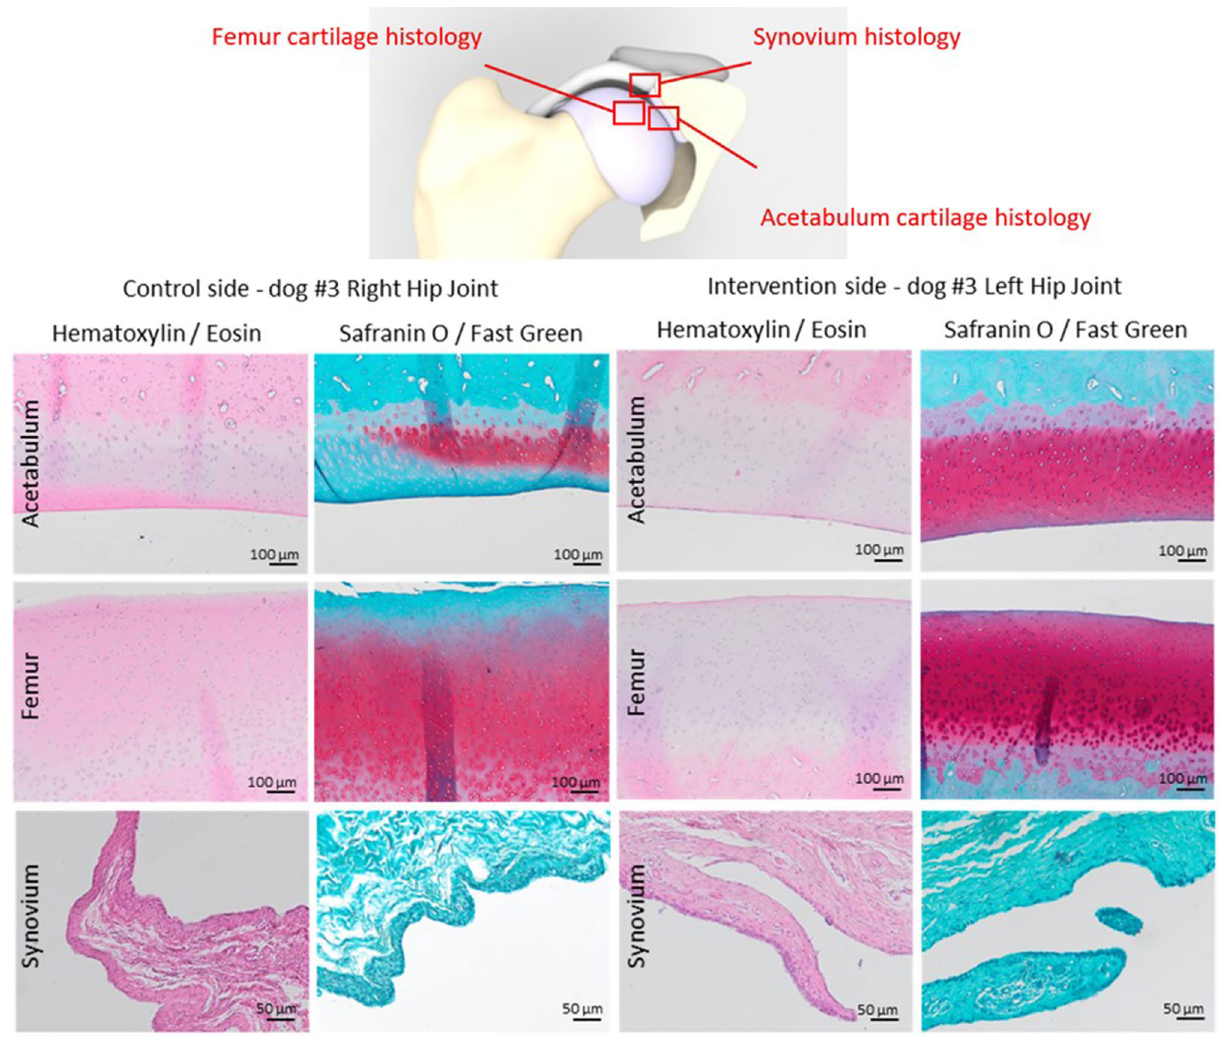
Figure 7. Representative histological images of the acetabular and femoral cartilage and synovium of dog #3. The control side demonstrates a fairly normal volume and smooth surface of acetabular and femoral cartilage, focal loss of proteoglycan staining into the deep zone of the acetabular cartilage, and global loss of proteoglycan staining into the upper zone of the femoral cartilage. The intervention side demonstrates a normal volume and smooth surface of acetabular and femoral cartilage, and unremarkable corresponding Safranin O/Fast Green staining. For both sides there are no abnormalities observed in the tide mark, nor subchondral changes. The synovial lining is composed of 2–3 layers of cells at the control side, whereas at the interventional side it is composed of 1–2 layers of cells. Both sides demonstrate absence of cell infiltrates, and proteoglycan